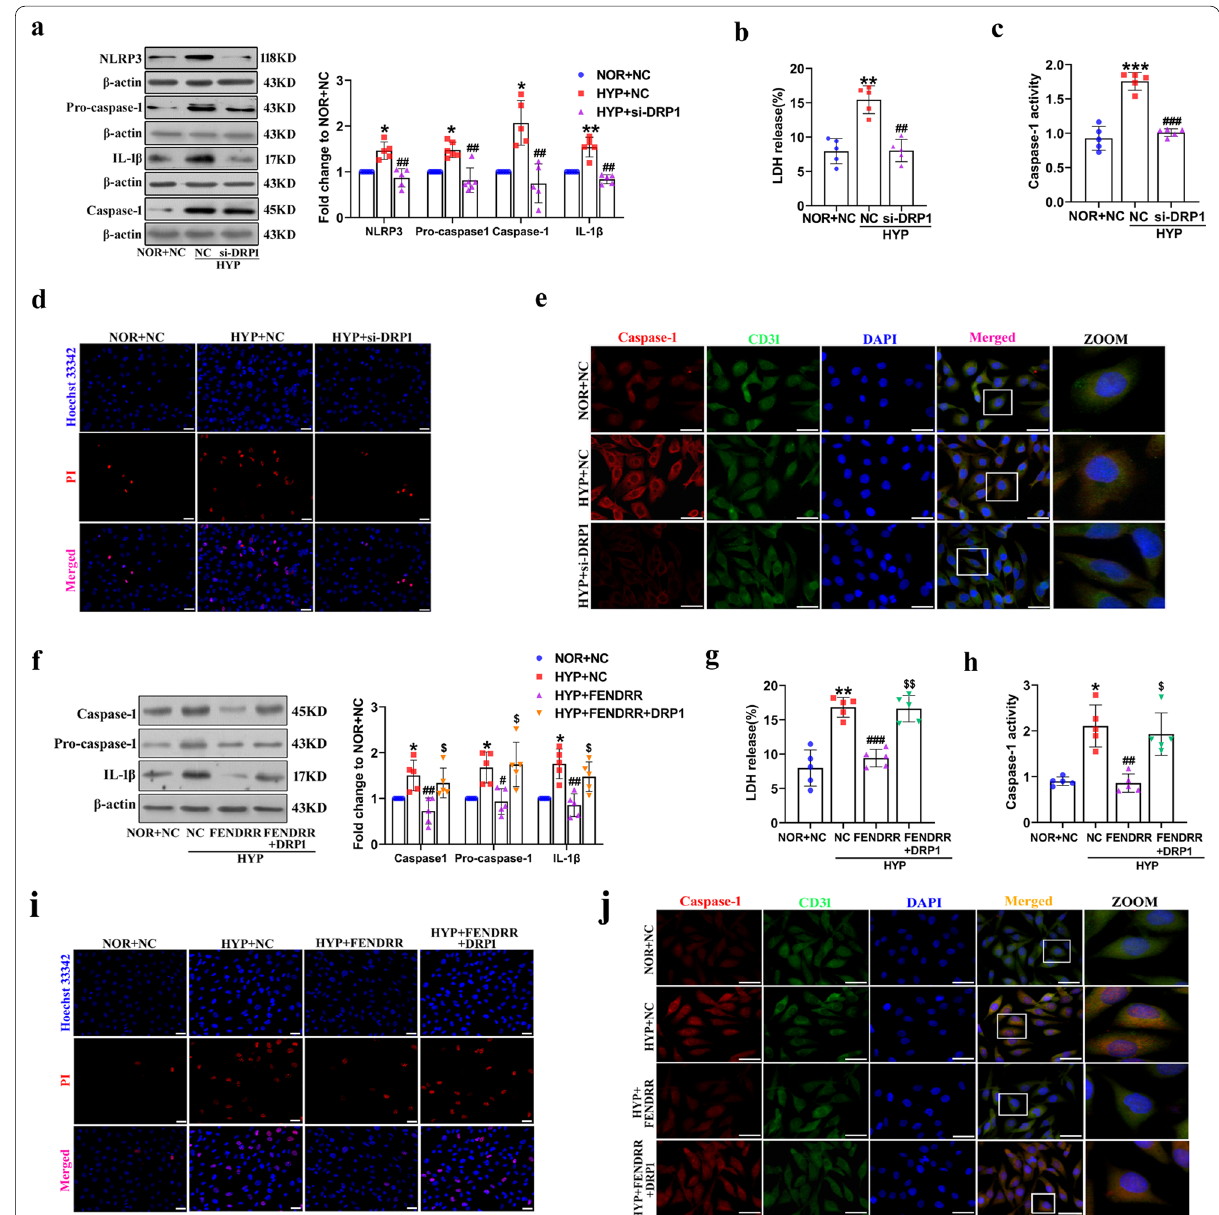
Fig. 5 FENDRR regulates HPAECs pyroptosis via DRP1. a After transfection with DRP1 siRNA, Western blot was used to examine the protein levels of Caspase-1, NLRP3, Pro-caspase-1 and IL-1β (n 5). b LDH release assays were used to determine the effects of DRP1 on HPAECs pyroptosis (n 5). = = c The activity of caspase-1 was examined using caspase-1 activity assay kit (n 5). d Images of fluorescence staining with PI (red) and Hoechst = 33,342 (blue) were used to detect PI-positive stained cells. Scale bar 50 μm. e Immunofluorescence analysis of Caspase-1 (red) and CD31 (green) = expression. Scale bar 50 μm. f After cotransfection with FENDRR and DRP1 overexpression plasmid, Western blotting was used to examine the = protein levels of Caspase-1, NLRP3, Pro-caspase-1 and IL-1β (n 5). g and h LDH release assays and activity of caspase-1 were used to determine the = effects of cotransfection with FENDRR and DRP1 overexpression plasmid on HPAECs pyroptosis (n 5). i and j PI staining and fluorescence intensity = of Caspase-1 were used to determine the effects of cotransfection with FENDRR and DRP1 overexpression plasmid on HPAECs pyroptosis. Each datapoint in the figure represents a unique biological replicate. All values are presented as the mean SD. Statistical analysis was performed with ± one-way ANOVA. NOR: normoxic; HYP: hypoxic; NC: negative control. **P < 0.01, *P < 0.05 compared with NOR NC. # p < 0.05, ## p < 0.01, ### p < 0.001 + versus HYP NC. $ p < 0.05, $$ p < 0.01 compared with HYP + +